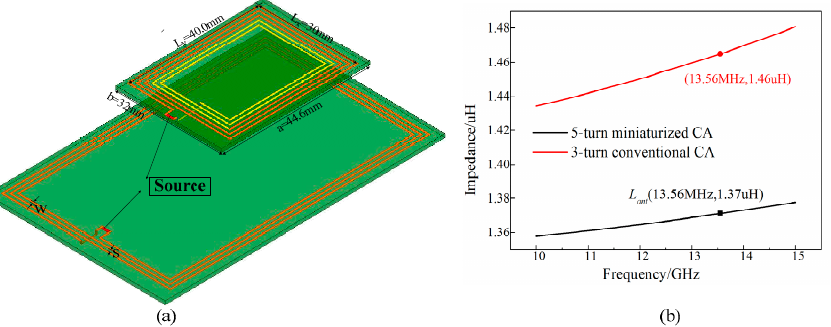
Figure 6. A comparison between three- and five-turn CA in simulation; ( a ) perspective geometry; ( b ) values of inductance.